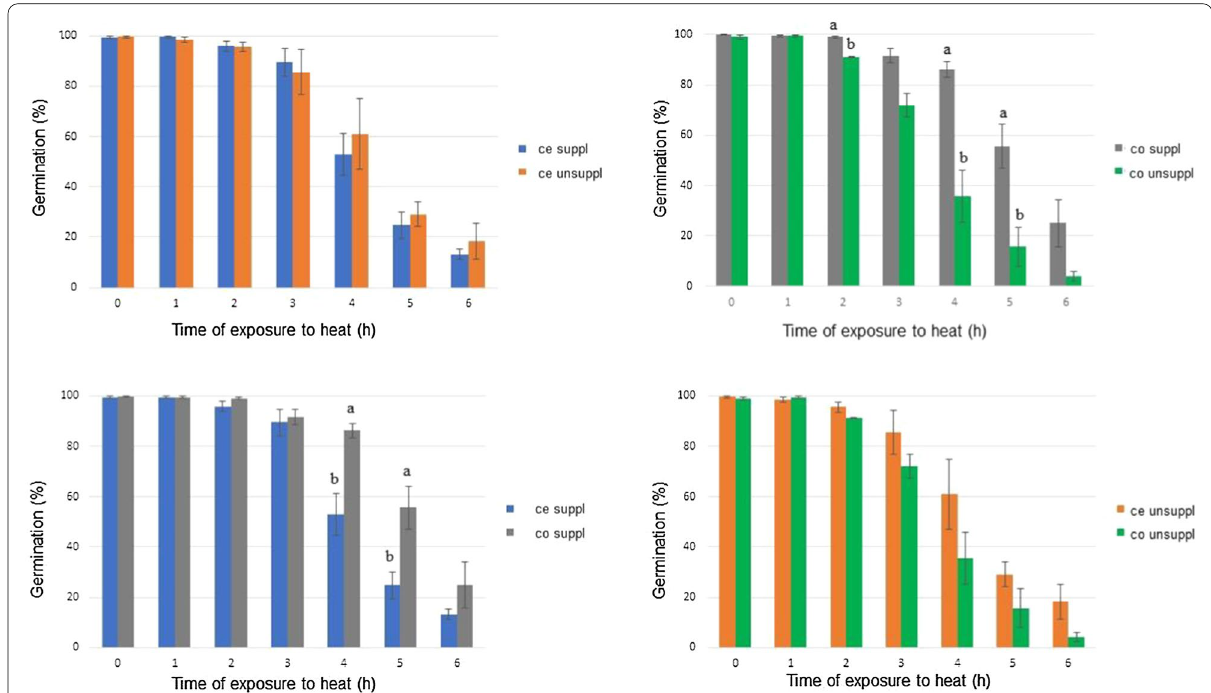
Fig. 3 Comparison between relative viability (%) of Metarhizium robertsii ARSEF 2575 produced in parboiled rice supplemented and unsupplemented with riboflavin and sodium nitrate after exposure to heat stress. Rice was washed with Tween 80 ® (0.01% v/v) after twenty days of solid fermentation. One part of the crude extract was kept and the other part was centrifugates, filtered and conidia were resuspended in Tween 80 ® (0.01% v/v). Samples of each group were exposed to 45 0.2 °C and at each 1 h of exposure an aliquot was inoculated in culture ± medium for germination analysis. Different treatments were compared at the same exposure times: A: Crude extract produced in supplemented and unsupplemented medium; B: Conidia produced in supplemented and unsupplemented medium; C: Crude extract and conidia produced in supplemented medium; D: Crude extract and conidia produced in unsupplemented medium. Samples of each group were exposed to 45 0.2 °C ± and at each 1 h of exposure an aliquot was inoculated in culture medium for germination analysis. Different letters indicates *P < 0.05 according